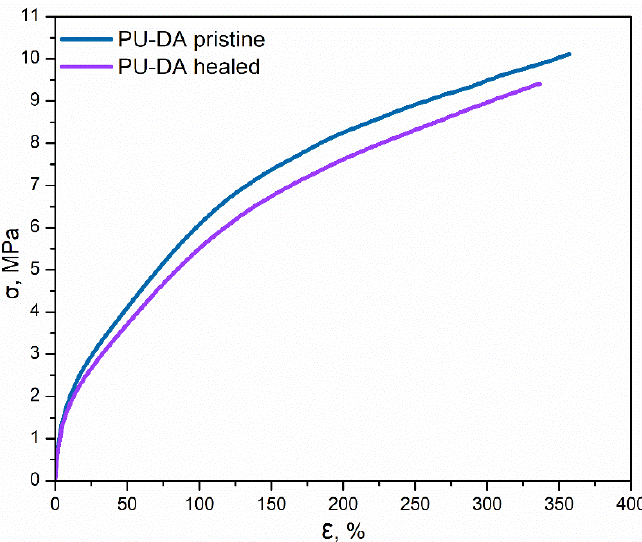
Figure 5. Representative loading diagrams for pristine and healed samples of PU-DA.